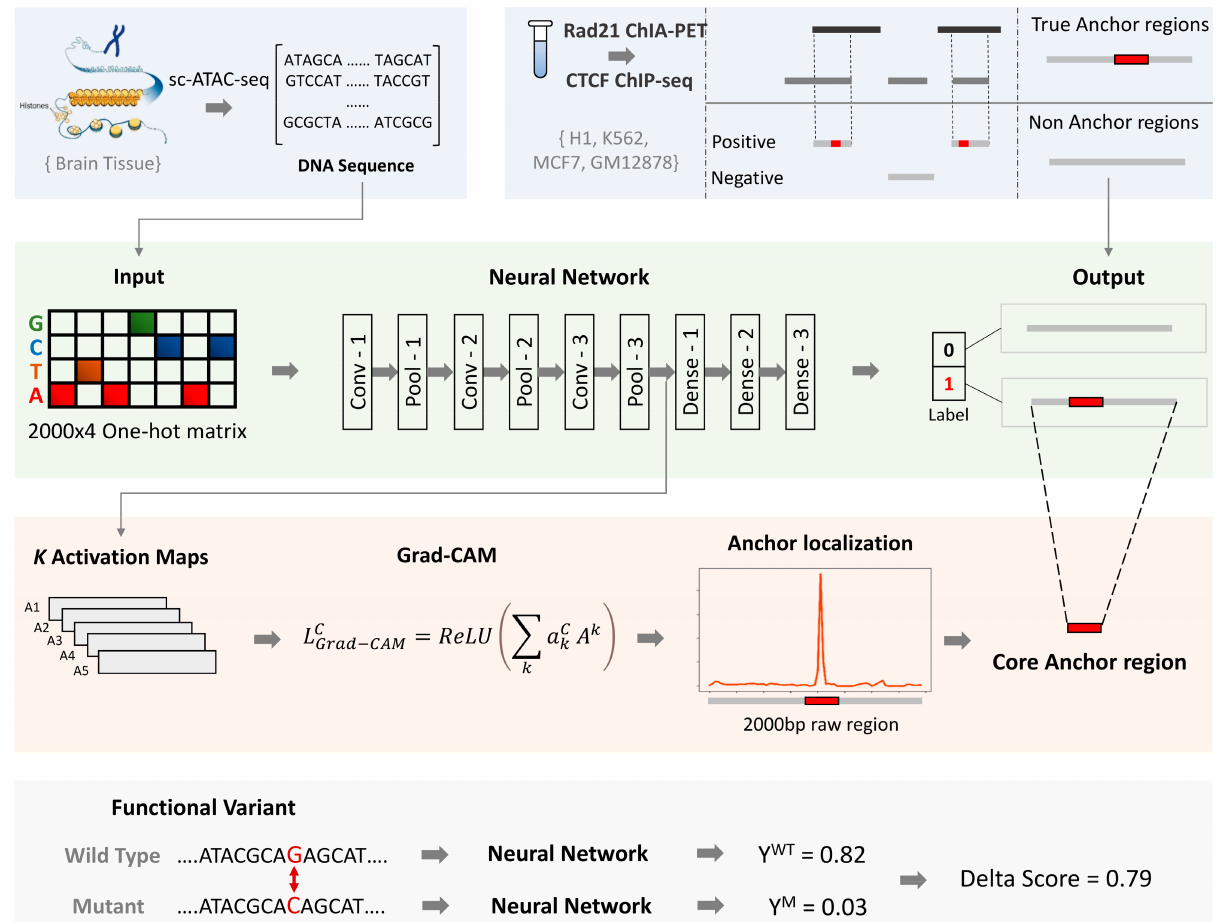
Figure 1. Overall schematic workflow of the InsuLock Method: First, the positive dataset is generated by intersecting Rad21 ChIA-PET peaks with CTCF ChIP-seq peaks to define true anchor regions. InsuLock utilizes one-hot encoded DNA matrices as input to make predictions. Second, the binary- classification module learns the sequence patterns around the anchors of insulator loops and makes a binary prediction. Third, the weakly-supervised object detection module utilizes the activation maps ( A k ), weighted by an importance score ( a c ) to refine and localize the core anchor region and visualize the sequence features that were used by the model to make the prediction. Fourth, the variant impact quantification module identifies insulator disrupting variants by computing a delta